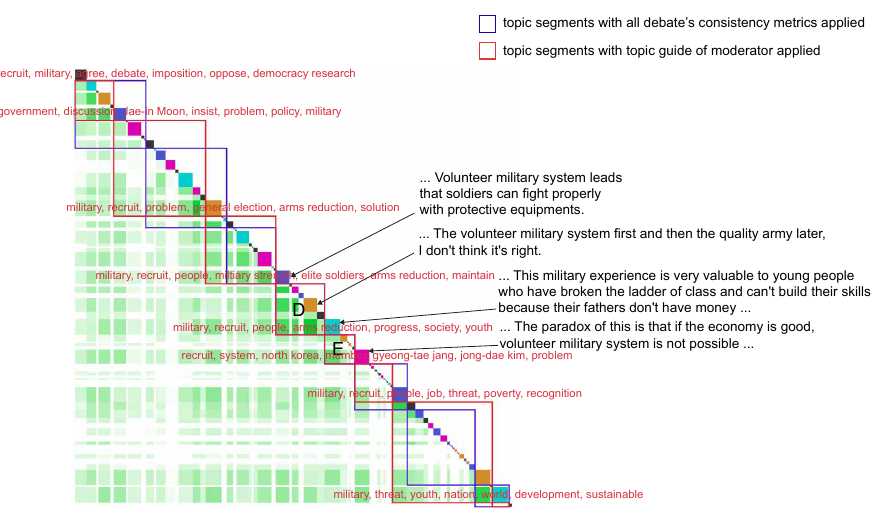
Figure 33. Result of comparing a case where weight of “other-continuity”, “self-continuity” was applied and a case where all weights of debate consistency metrics were applied. Red squares are topic segments of a result weighted only by “other-continuity and self-continuity”, and blue squares are topic segments of a result weighted by all debate consistency